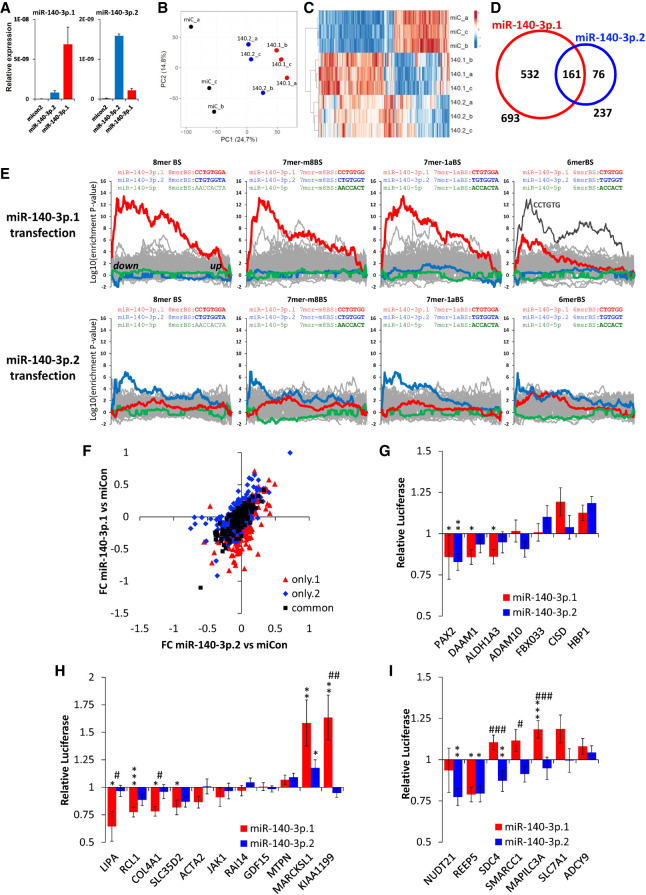
Identification and validation of miR-140-3p.1 and miR-140-3p.2 targets in human chondrocytes. (A) qRT-PCR for miR-140-3p.1 and miR-140-3p.2 following transfection of either control mimic, miR-140-3p.1 mimic or miR-140-3p.2 mimic for 48 h. (B) PCA of whole genome micro-array following transfection of mimics described in (A), (140.1 = miR-140-3p.1 and 140.2 = miR-140-3p.2). (C) Heat map of whole genome micro-array following transfection of mimics as described in (A) (140.1 = miR-140-3p.1 and 140.2 = miR-140-3p.2). (D) Venn diagram indicating the number of genes down-regulated following overexpression of miR-140-3p.1 and miR-140-3p.2. (E) Enrichment analysis using Sylamer for 3′UTR mRNA motifs complementary to either miR-140-3p.1 or miR-140-3p.2 seed sequences in genes whose expression decreased following transfection of either miR-140-3p mimic, miR-140-3p.1 mimic, or miR-140-3p.2 mimic. (F) Gene expression changes of miR-140-3p.1 (only.1; red triangles), miR-140-3p.2 (only.2; blue diamonds), or miR-140-3p.1 and miR-140-3p.2 (common; black squares) predicted targets following transfection of either miR-140-3p.1 mimic or miR-140-3p.2 mimic. (G–I) 3′UTR luciferase reporters for both miR-140-3p.1 and miR-140-3p.2 (G), miR-140-3p.1 (H), or miR-140-3p.2 (I) putative targets. (*), (**), or (***) indicate level of significance (P < 0.05, 0.01, or 0.001, respectively) of either miR-140-3p.1 or miR-140-3p.2 to control. # indicates level of significance (P < 0.05, 0.01, or 0.001, respectively) between miR-140-3p.1 and miR-140-3p.2.